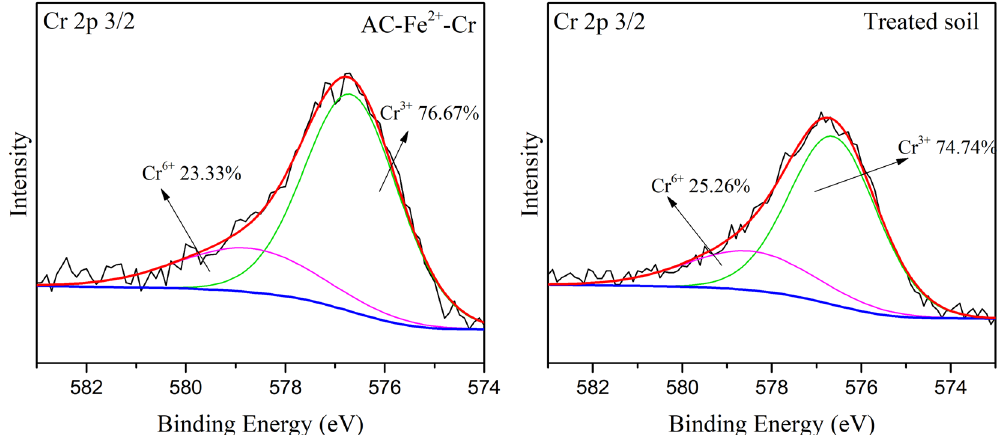
Figure 10. Cr 2p 3/2 spectra of the soil and electrode particles after remediation (AC-Fe-Cr).